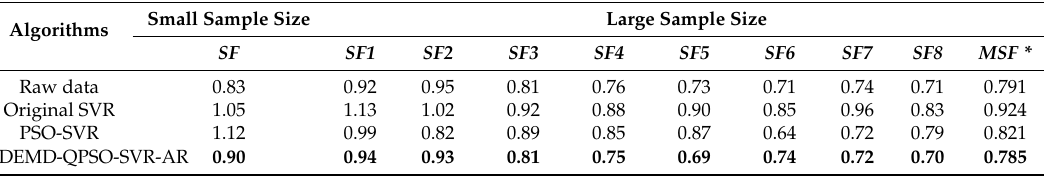
Table 6. The shape factor ( SF ) for local sharp points comparison.